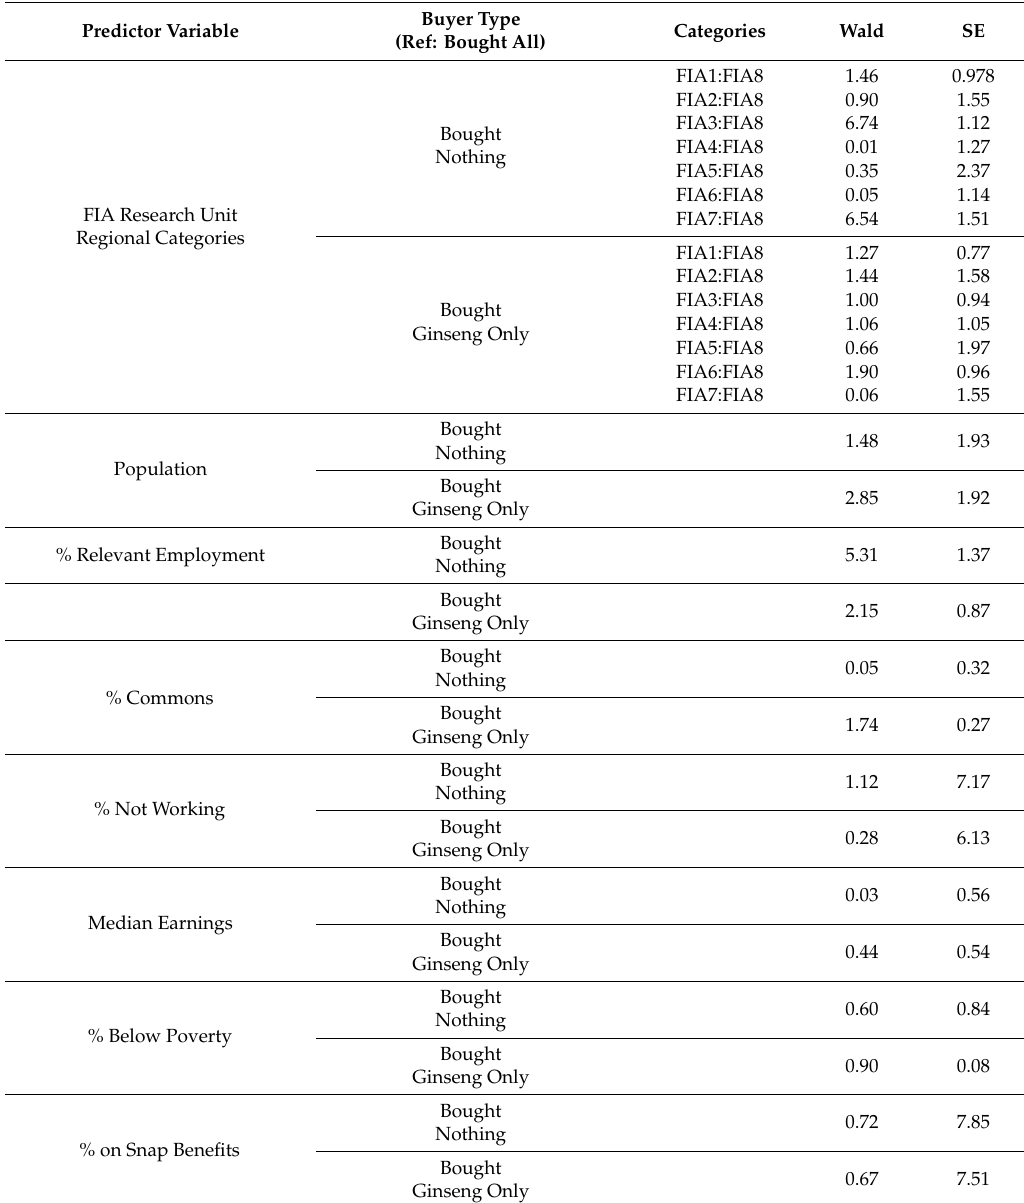
Table A1. Multinomial regression